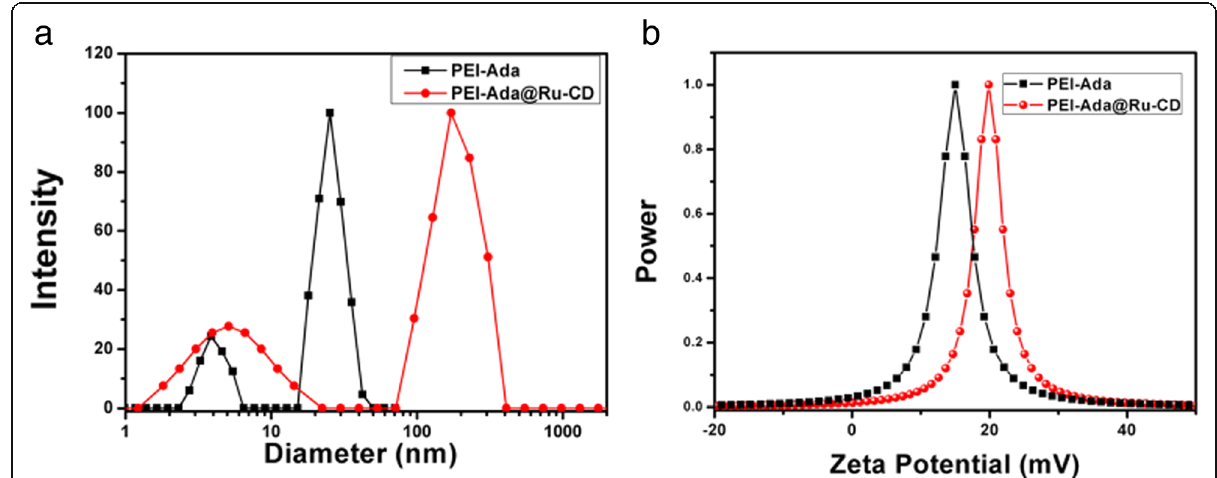
Fig. 3 a Hydrodynamic diameter distributions and b zeta potentials of PEI-Ada and PEI-Ada@Ru-CD